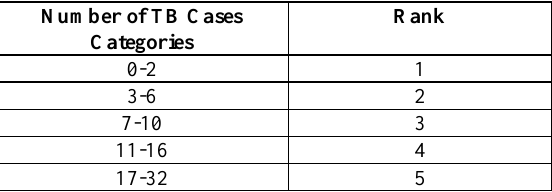
Table 1. Weightage indicator for SNA.